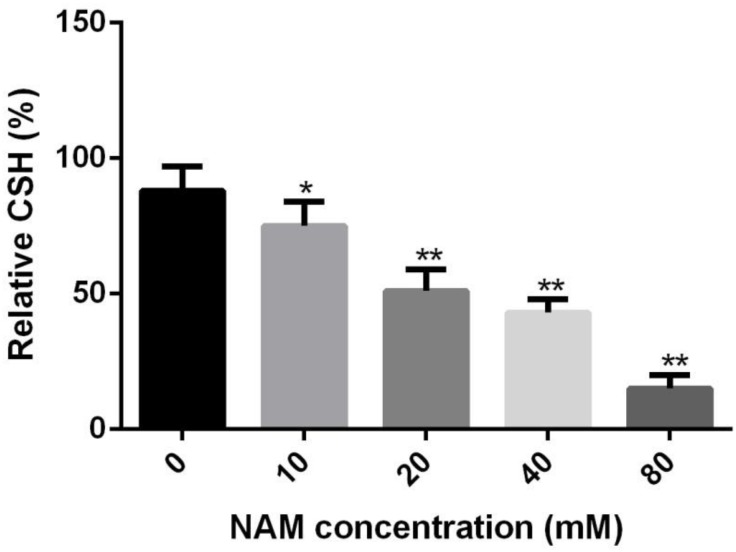
Effects of NAM on the cell surface hydrophobicity (CSH). C. albicans cells were treated with different concentrations of NAM for 16 h and then CSH was estimated by the water-hydrocarbon two-phase assay. Data are expressed as the mean ± standard deviation of the independent assays in triplicate. ∗P < 0.05; ∗∗P < 0.01 as compared to the NAM-free group.